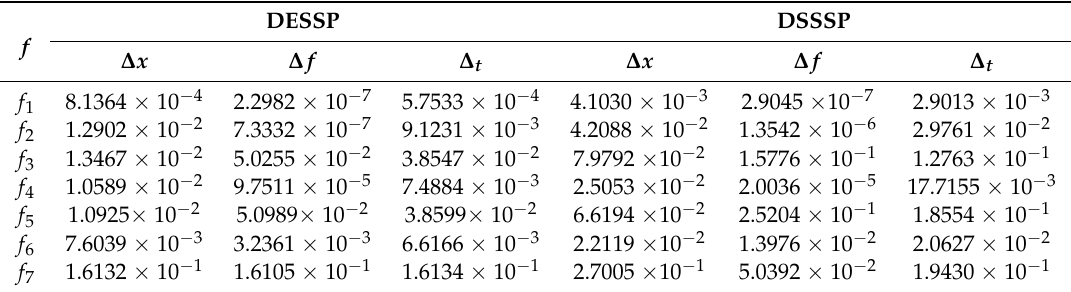
Table 10. Averages of normalized Euclidean distances obtained by the DESSP and DSSSP methods. DESSP DSSSP